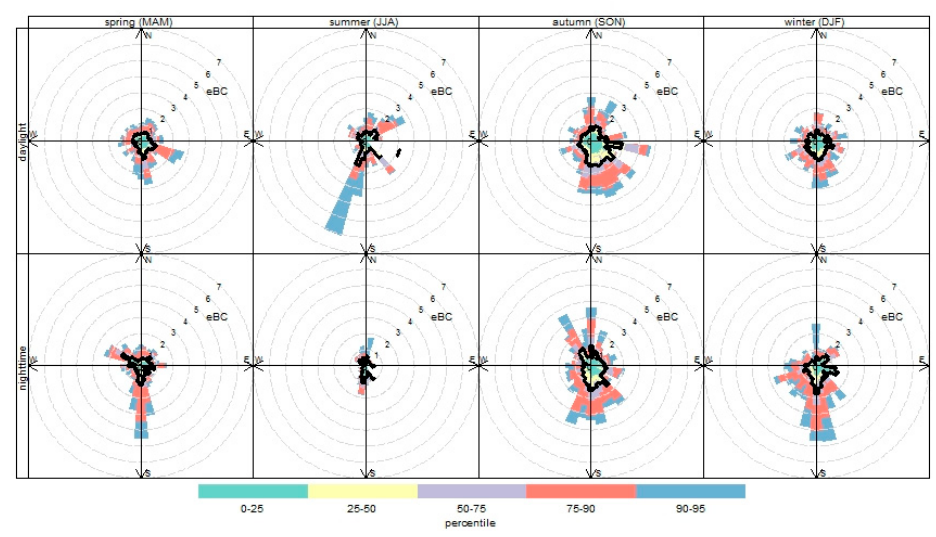
Figure 3. Percentile rose plot of eBC concentrations ( µ g m − 3 ).